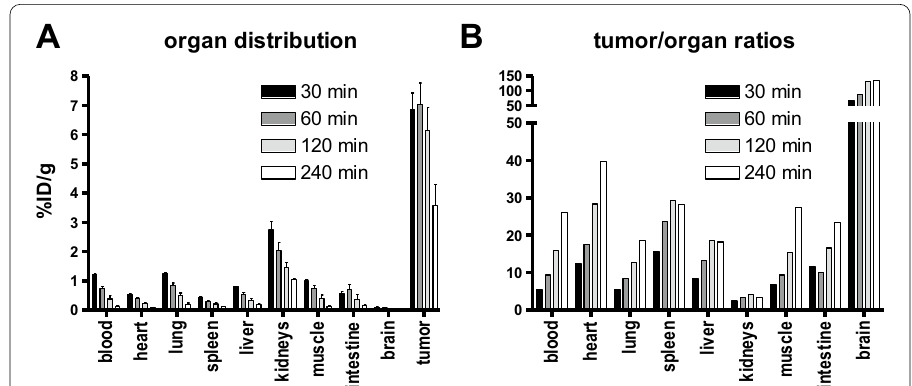
Fig. 3 Biodistribution study of [ 18 F]AlF‑FAPI‑74. Accumulation in different tissues ( A ) and tumor‑to‑organ ratios ( B ) in HT‑1080‑FAP bearing Balb/c nu/nu mice 30, 60, 120, and 240 min after